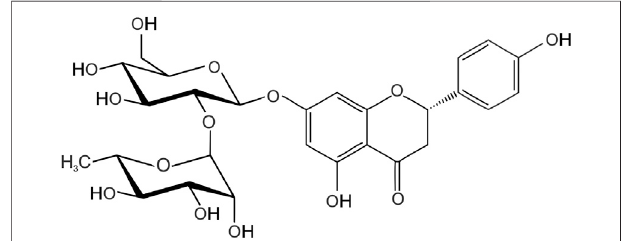
FIGURE 1 | The chemical structure of